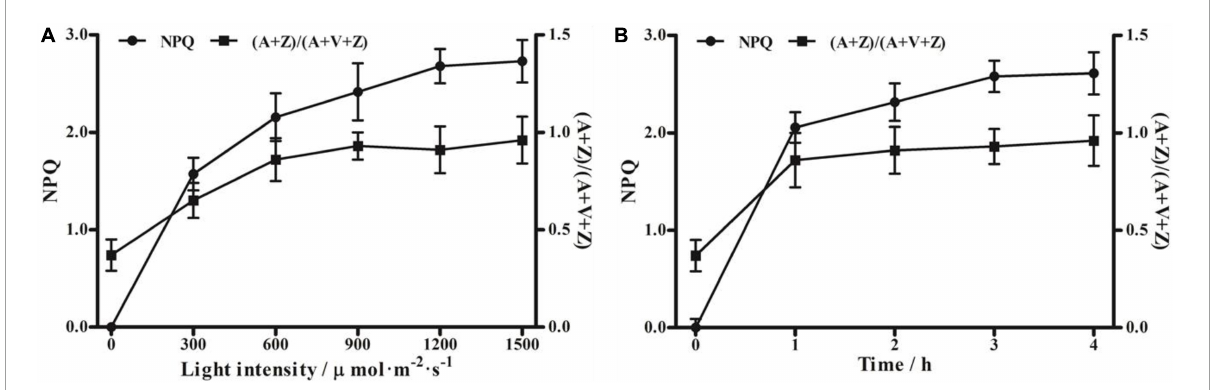
FIGURE2 Non-photochemical quenching (NPQ) and de-epoxidation of the violaxanthin cycle in moso bamboo under different light conditions. (A) Treatment with different light intensities (0, 300, 600, 900, 1,200, and 1,500 µ mol · m − 2 · s − 1 ) for 2 h after dark adaptation for 24 h.